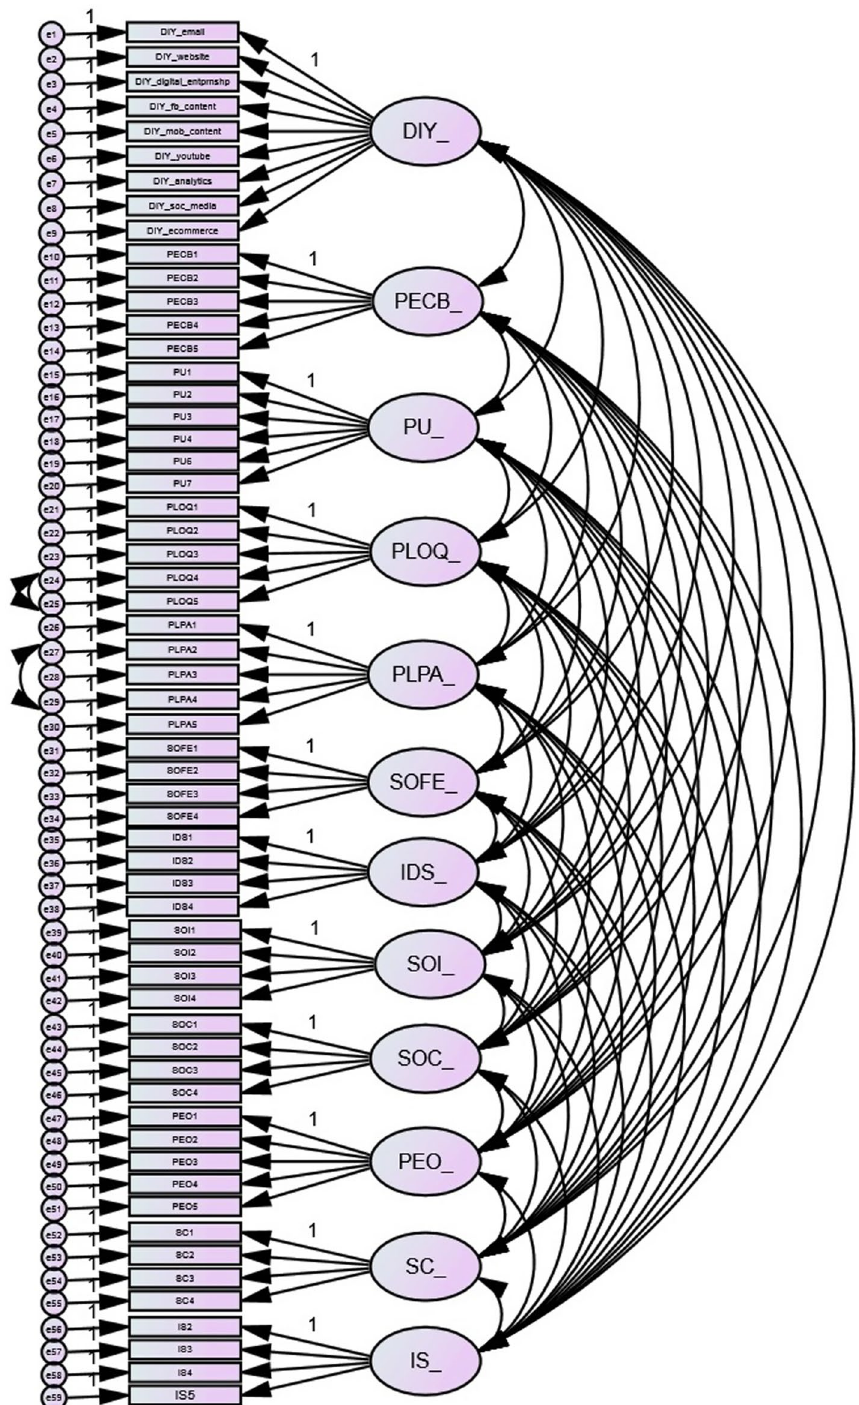
Fig. 2 Measurement